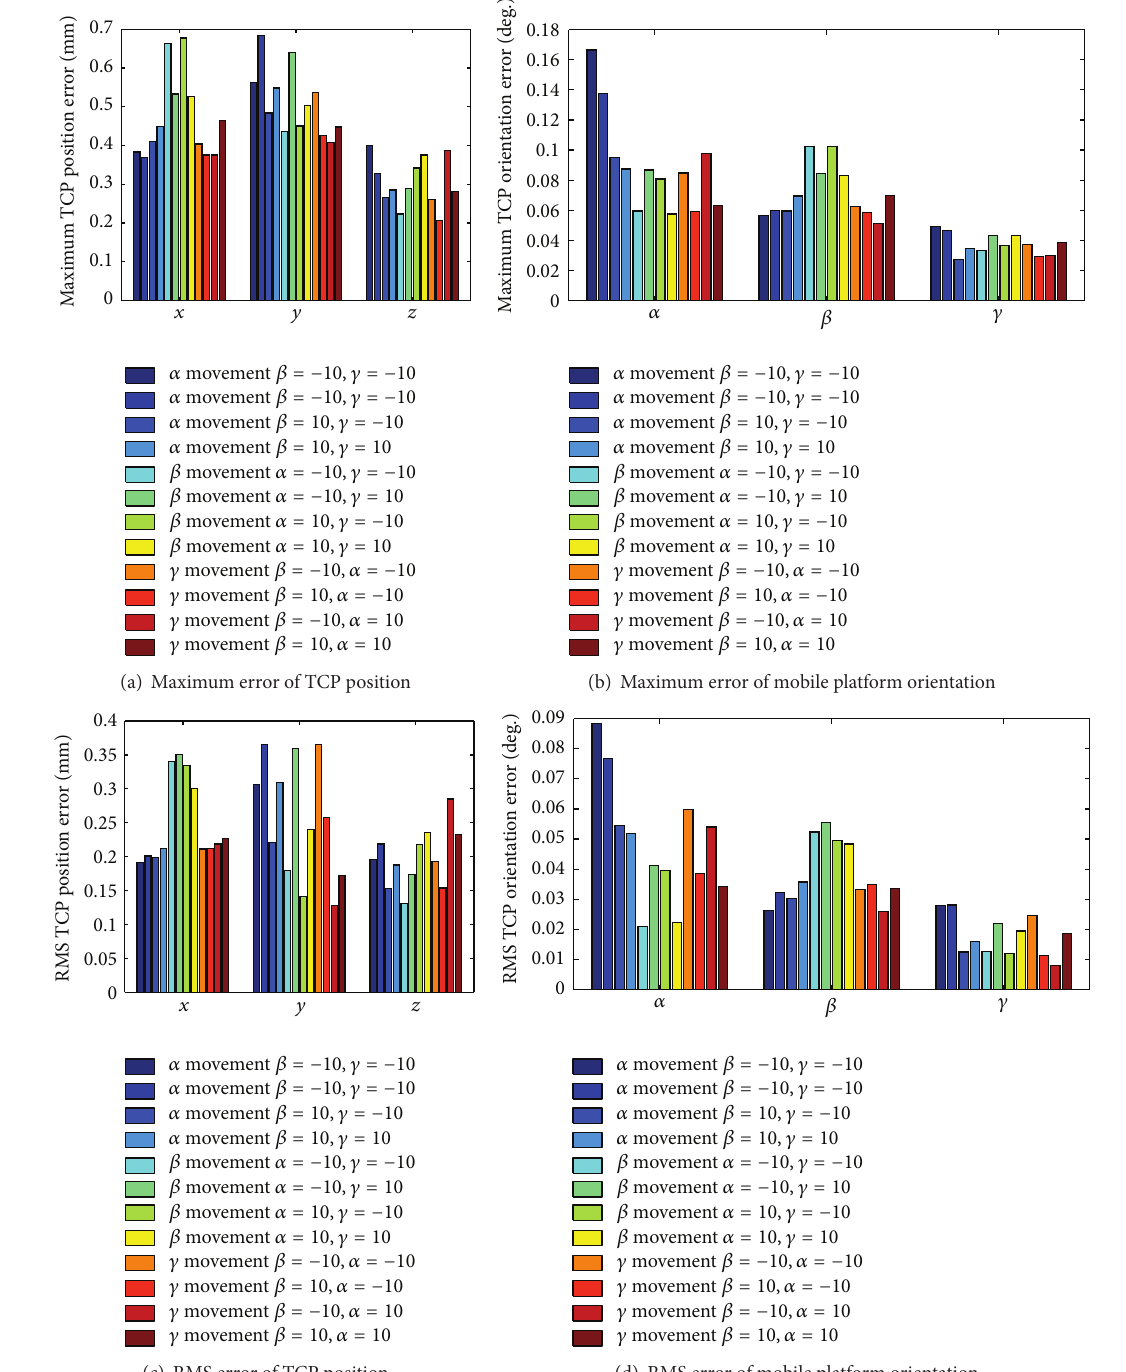
Figure 8: Maximum and RMS of pose error when sailboat is installed on